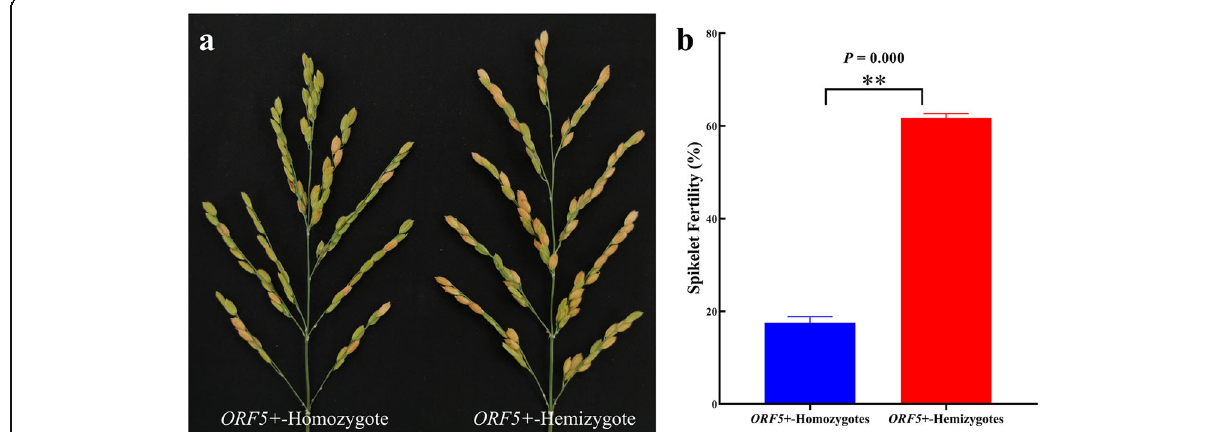
Fig. 3 Effect of transgene ORF5+ on spikelet fertility in BC 6 F 4 families. a Spikelet fertility of homozygote (left) and hemizygote (right) of ORF5+ transgene. b Mean spikelet fertility value of homozygotes (left) and hemizygotes (right) of ORF5+ transgene. Data represent means ± SEM. Significant differences are indicated by ** P <